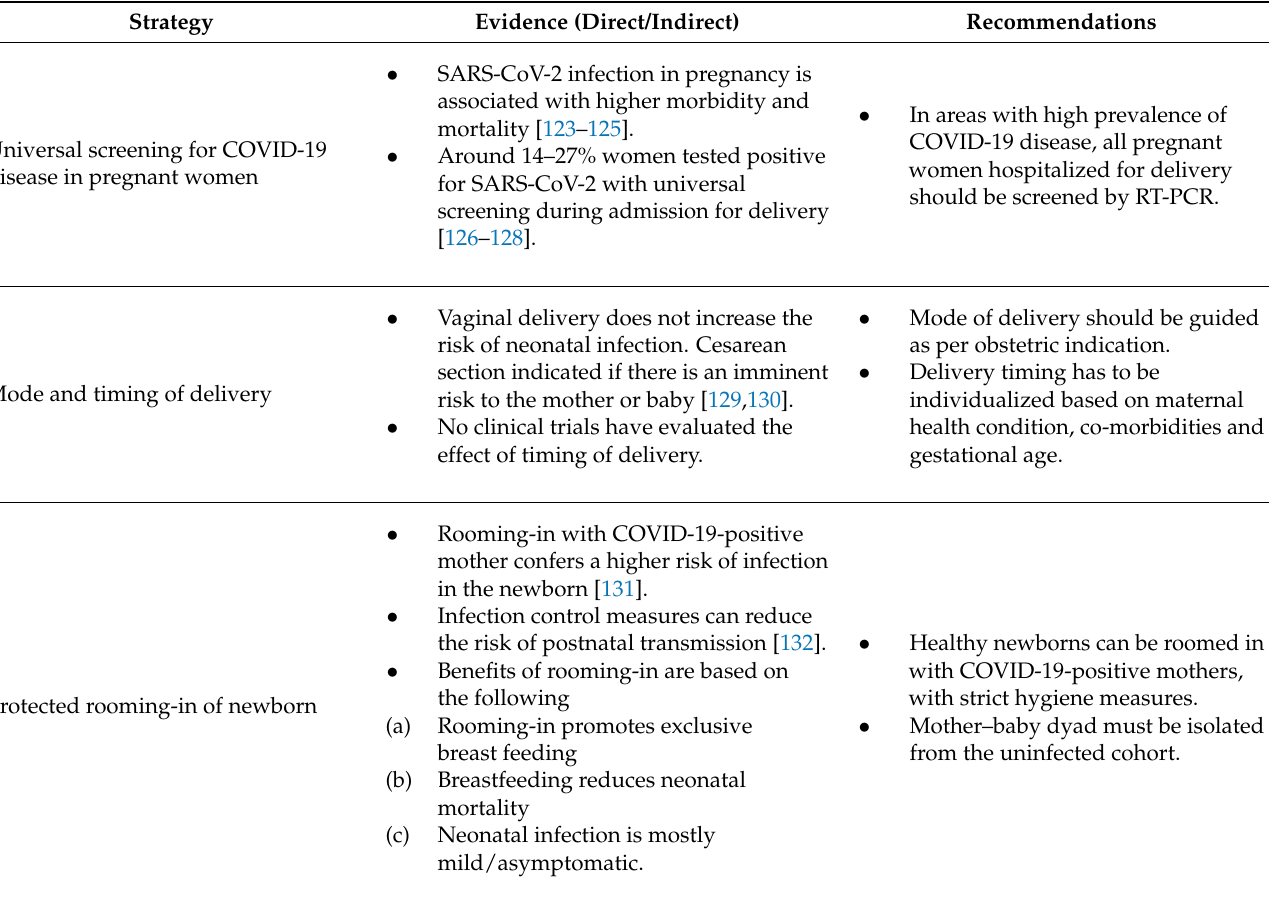
Table 2. Preventive strategies to reduce COVID-19